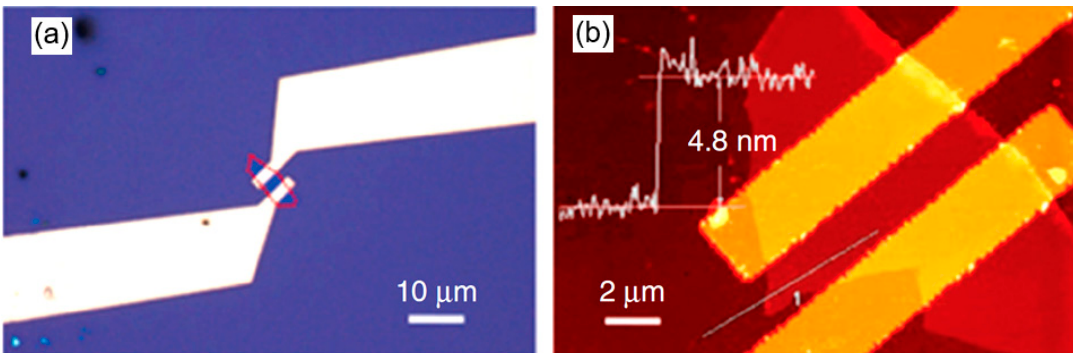
Figure 7. ( a ) Optical microscopy and ( b ) atomic force microscopy (AFM) images of the phosphorene nanosheet (PNS)-based FET sensor showing that the PNS electrically bridges the gold electrodes. The profile in ( b ) indicates the PNS has a thickness of 4.8 nm. Reproduced from Ref. [90]. Published by Macmillan Publishers Limited as open access, 2015.